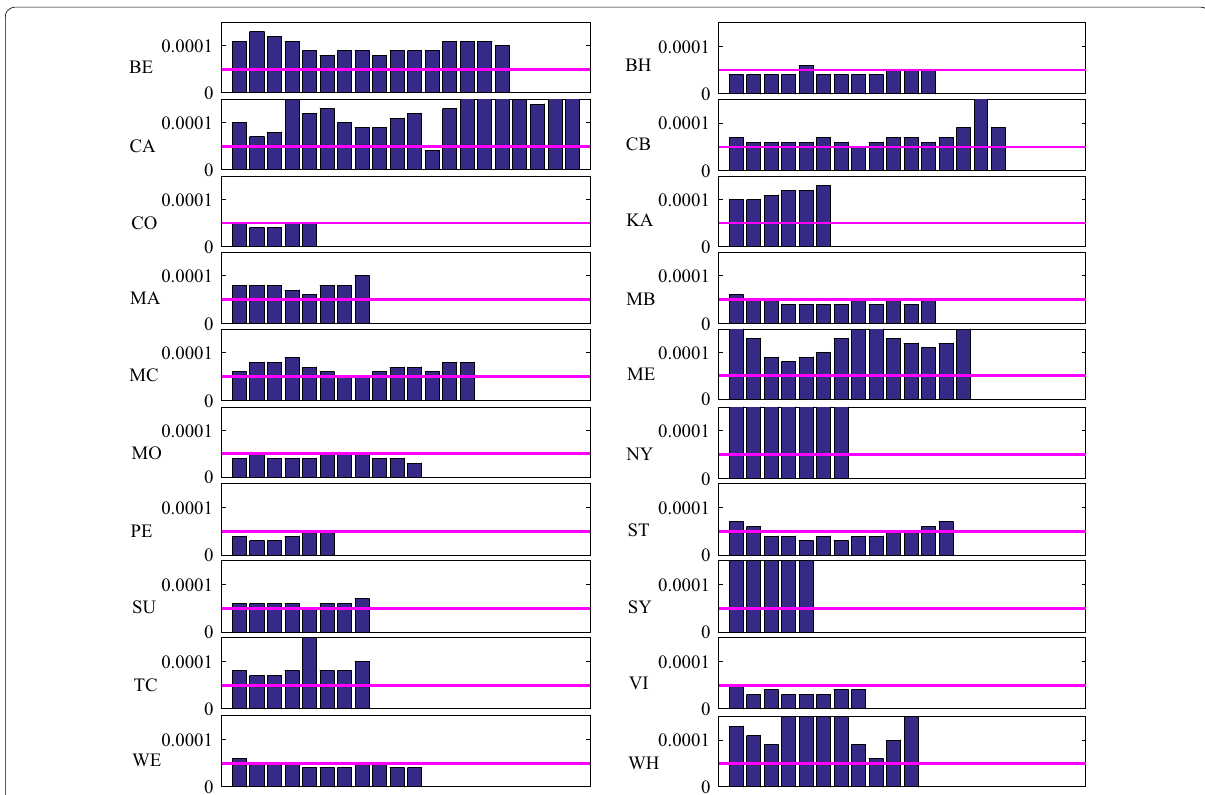
Fig. 6 Tidal analysis precision of 20 global stations. The vertical axis is the standard deviation of the amplitude factor of the K1 wave. The horizontal axis is the number of data segments by sliding time window to each observation. The violet line is the reference line for a standard deviation of 5 10 − ×